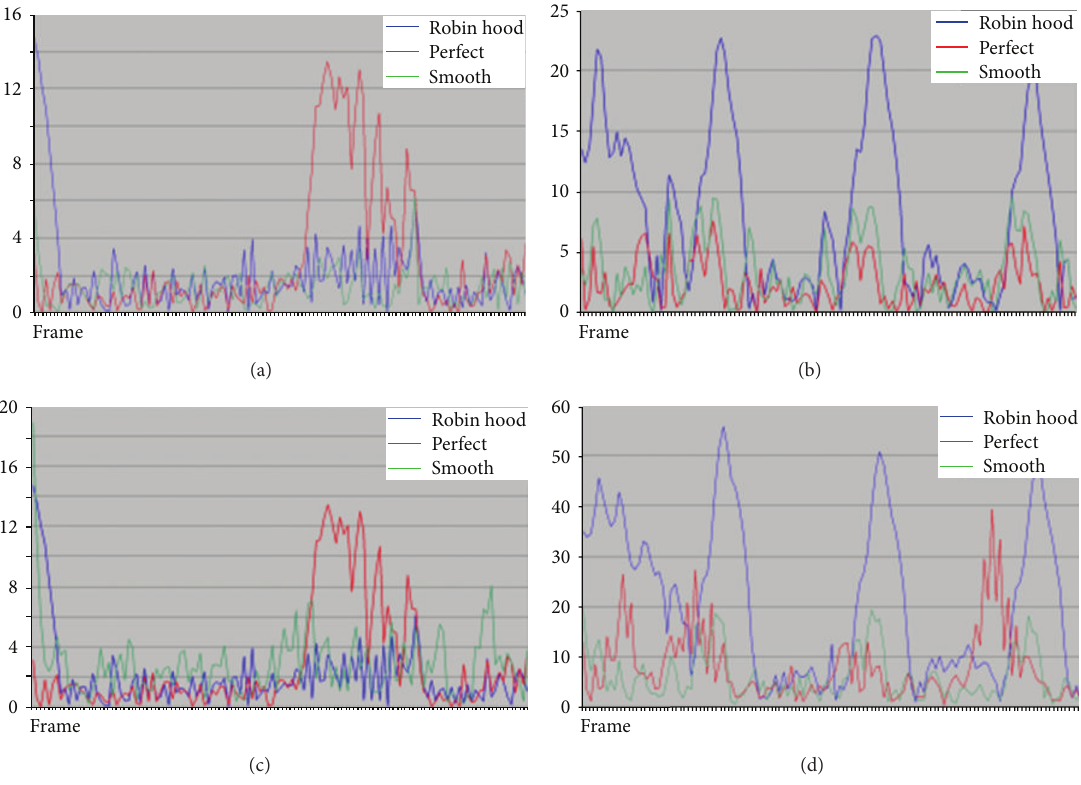
Figure 9: Efficiency of three workload balancing schemes, for two GPUs ((a)-(b)) and three GPUs ((c)-(d)), small camera movements ((a)– (c)) and larger camera movements ((b)–(d)). Values are percentages of rendering time spent idling due to early completion. Measured for the Aztec scene.